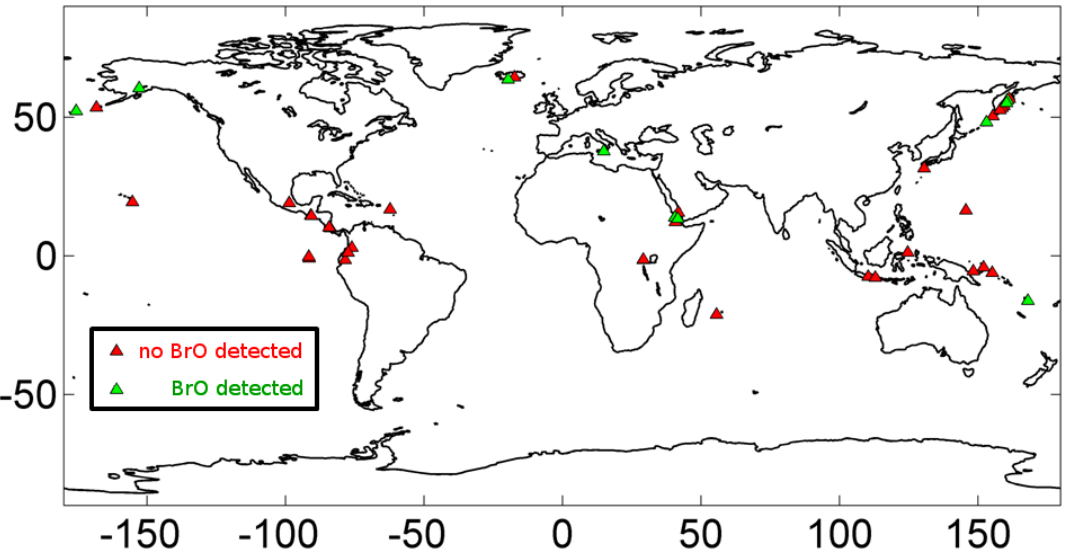
Fig. 17. Global map of the location of all volcanoes that were investigated within this study. In total, 64 volcanic plumes from 10–12 different volcanoes were found to show clear evidence for enhanced BrO column densities (green triangles). For all others, only SO 2 could be detected (red